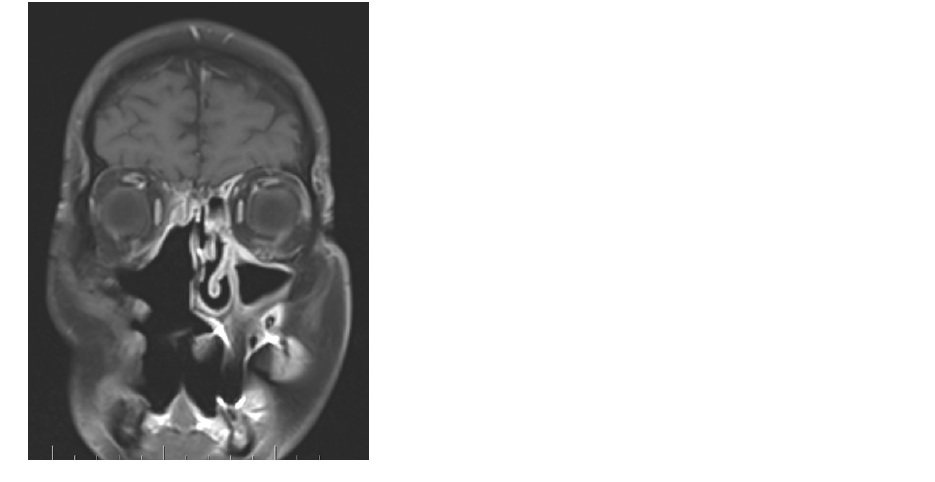
Figure 7. Follow-up MR imaging demonstrates a postresection cavity without tumour residue or recurrence in the right maxilla (5 years after surgical treatment). Coronal imaging in T1 weighting after contrast agent administration.